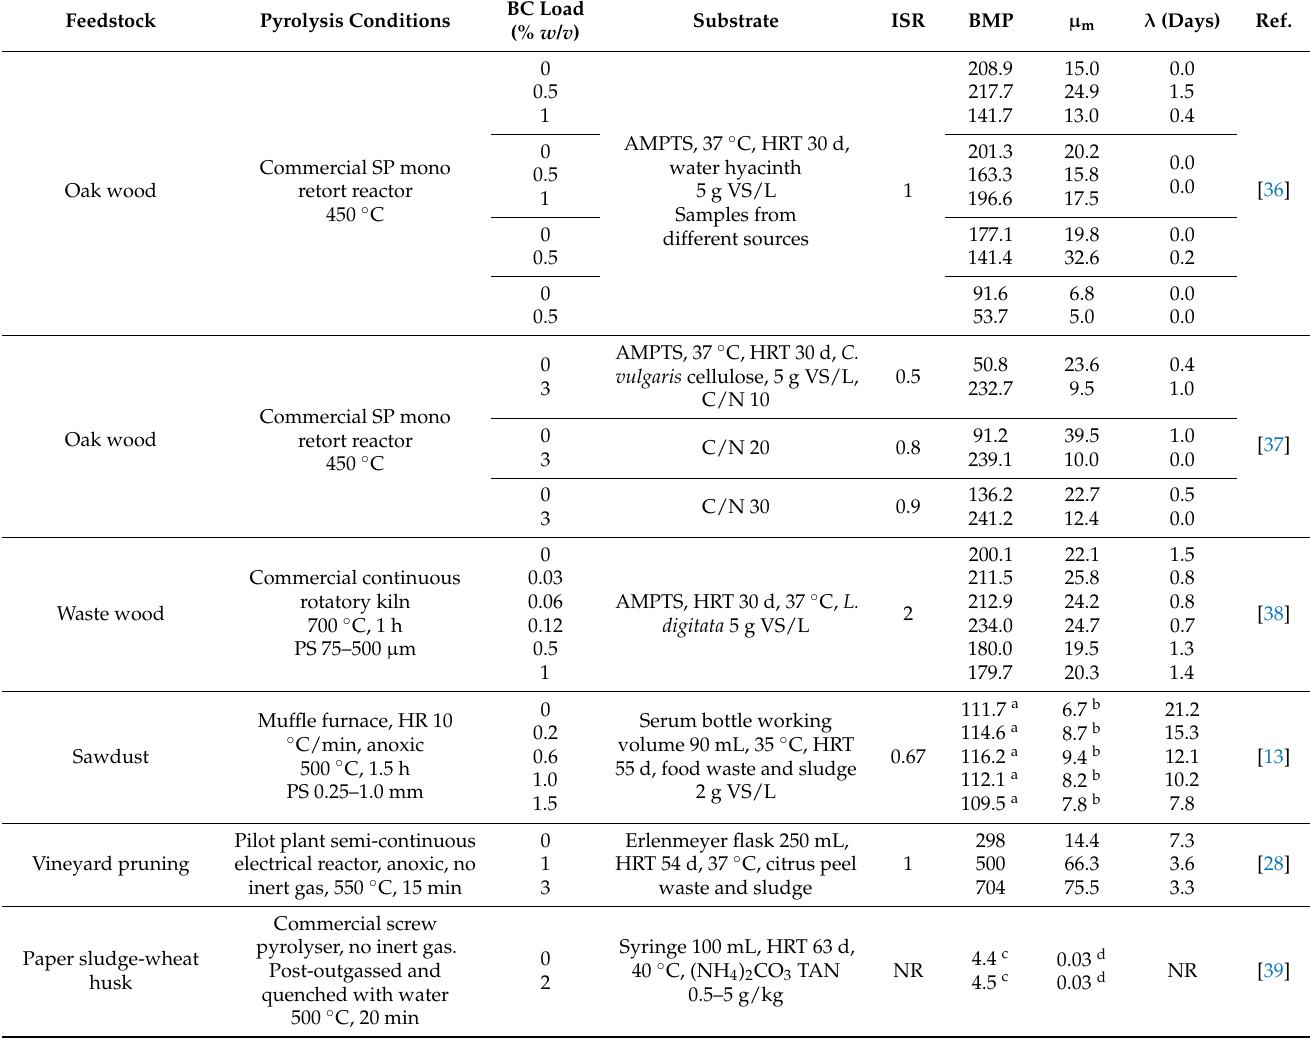
Table 4. Summary of the reports for the biochar addition on anaerobic digestion of aquatic plants, algae, ammonium carbonate and anaerobic co-digestion of multiple